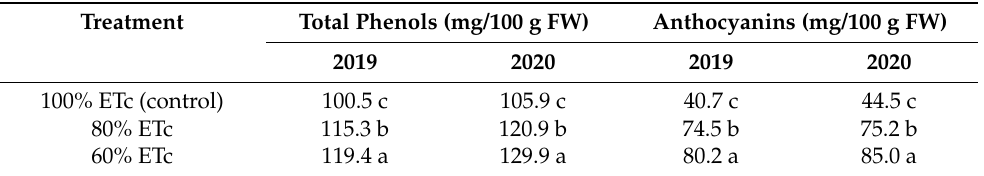
Table 7. Effect of deficit irrigation (as a percentage of crop evapotranspiration, ETc) on total phenol and anthocyanin contents of ‘African Rose’ plum fruit during the 2019 and 2020 seasons ( n = 10).